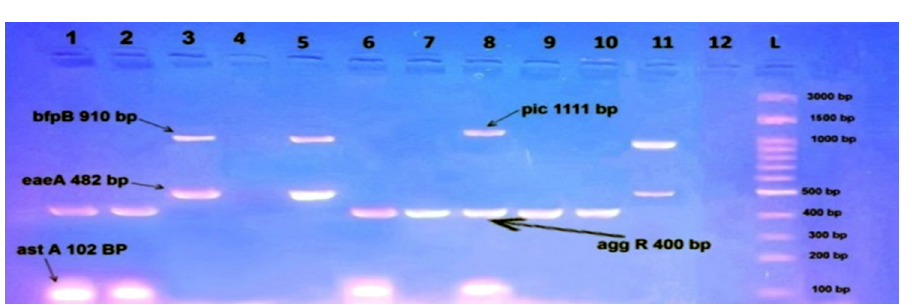
Fig. 2. Gel electrophoresis of amplified ( eaeA , bfpB, aggR ,astA ,pic ,hly ,stx1 ,stx2 invE , ipaH, elt ,estIa ,estIb ) genes, the product size (482 , 910 , 400 , 102 , 1,111 , 688 , 244 , 324 , 766 , 437 , 655 , 157 , 171 ( bp ) respectively), of E .coli strains using conventional PCR . Agarose 2%, and TBE (1X ) at (75 V/cm for 90 min., stained with Ethydium bromide dye and visualized on a UV transilluminator. Lane(L): DNA ladder (100-3000 bp), Lanes: (1-12) stool samples.